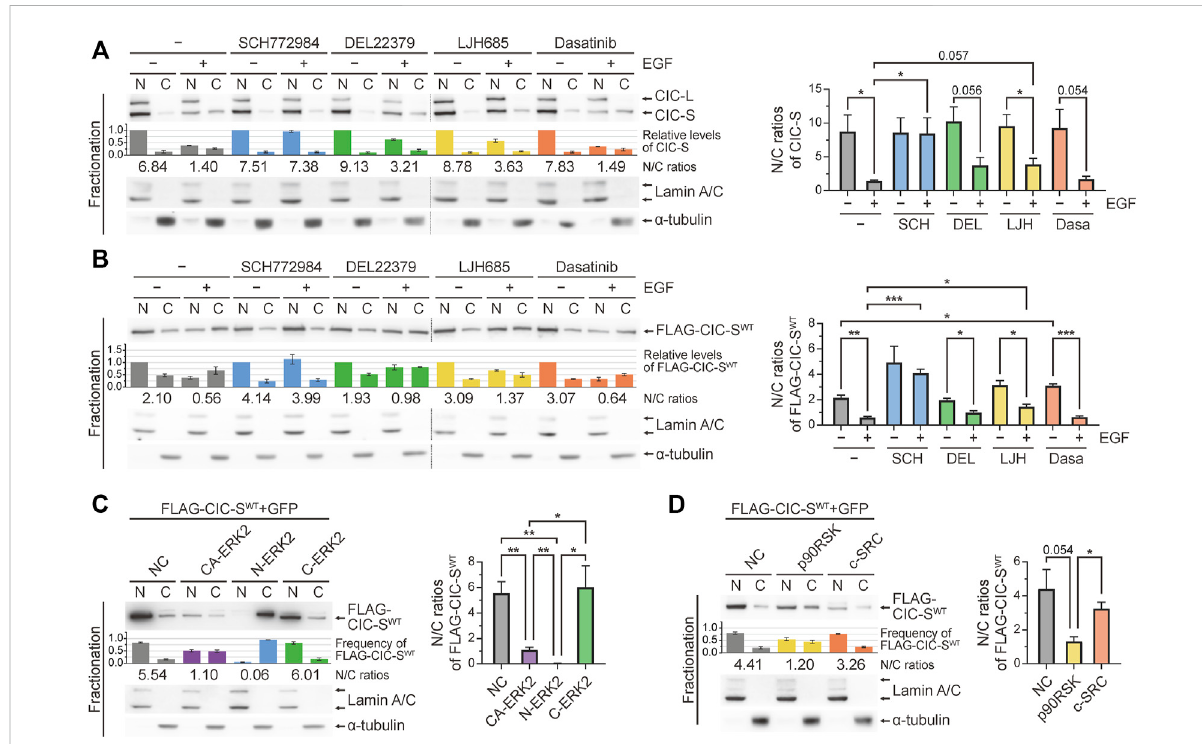
FIGURE 1 CytoplasmictranslocationofCIC-SmediatedbyERKactivation. (A) Westernblottingwasperformedtodeterminetheeffectofkinaseinhibitors on changes in the subcellular distribution of CIC in HEK293T cells upon EGF treatment for 30 min. The combination of separate blot images is indicatedbydottedlines.ThebargraphbelowtheCICblotimageshowstherelativelevelsofCIC-Sthatwerenotstatisticallyanalyzed.Thenumbers below the bar graph indicate the N/C ratios of CIC-S. The right panel is a bar graph of the N/C ratios of CIC-S with statistical analysis. Three independent experiments were performed. Error bars indicate SEM. * p < 0.05. SCH772984: ERK1/2 inhibitor, DEL22379: ERK dimerization inhibitor, LJH685:p90RSKinhibitor,anddasatinib:c-SRCinhibitor. (B) Westernblottingwasperformedtodeterminetheeffectofkinaseinhibitorsonchanges in the subcellular distribution of exogenous mouse CIC-S (FLAG-CIC-S WT ) in HEK293T cells upon EGF treatment for 30 min. The combination of separate blot images is indicated by dotted lines. The bar graph below the FLAG-CIC-S WT blot image shows the relative levels of FLAG-CIC-S WT that were not statistically analyzed. The numbers below the bar graph indicate the N/C ratios of FLAG-CIC-S WT . The right panel is a bar graph of the N/C ratios of FLAG-CIC-S WT with statistical analysis. Three independent experiments were performed. Error bars indicate SEM. * p < 0.05, ** p < 0.01, and *** p < 0.001. (C) Westernblottingwasperformedtodeterminetheeffectofoverexpressionofconstitutivelyactive(CA-ERK2),nuclear(N-ERK2),and cytoplasmic(C-ERK2)ERK2onthecytoplasmictranslocationofFLAG-CIC-S WT inHEK293Tcells.ThebargraphbelowtheFLAG-CIC-S WT blotimage shows the frequency of FLAG-CIC-S WT in the nucleus and cytoplasm, which were not statistically analyzed. The numbers below the bar graph indicatetheN/CratiosofFLAG-CIC-S WT .TherightpanelisabargraphoftheN/CratiosofFLAG-CIC-S WT withstatisticalanalysis.Threeindependent experiments were performed. Error bars indicate SEM. * p < 0.05 and ** p < 0.01. (D) Western blotting was performed to determine the effect of overexpression of p90RSK and c-SRC on the cytoplasmic translocation of FLAG-CIC-S WT in HEK293T cells. The bar graph below the FLAG-CIC-S WT blot image shows the frequency of FLAG-CIC-S WT in the nucleus and cytoplasm, which were not statistically analyzed. The numbers below the bar graph indicate the N/C ratios of FLAG-CIC-S WT . The right panel is a bar graph of the N/C ratios of FLAG-CIC-S WT with statistical analysis. Three independent experiments were performed. Error bars indicate SEM. * p < 0.05. N: nuclear fraction and C: cytoplasmic fraction. N/C: nuclear-to- cytoplasmic